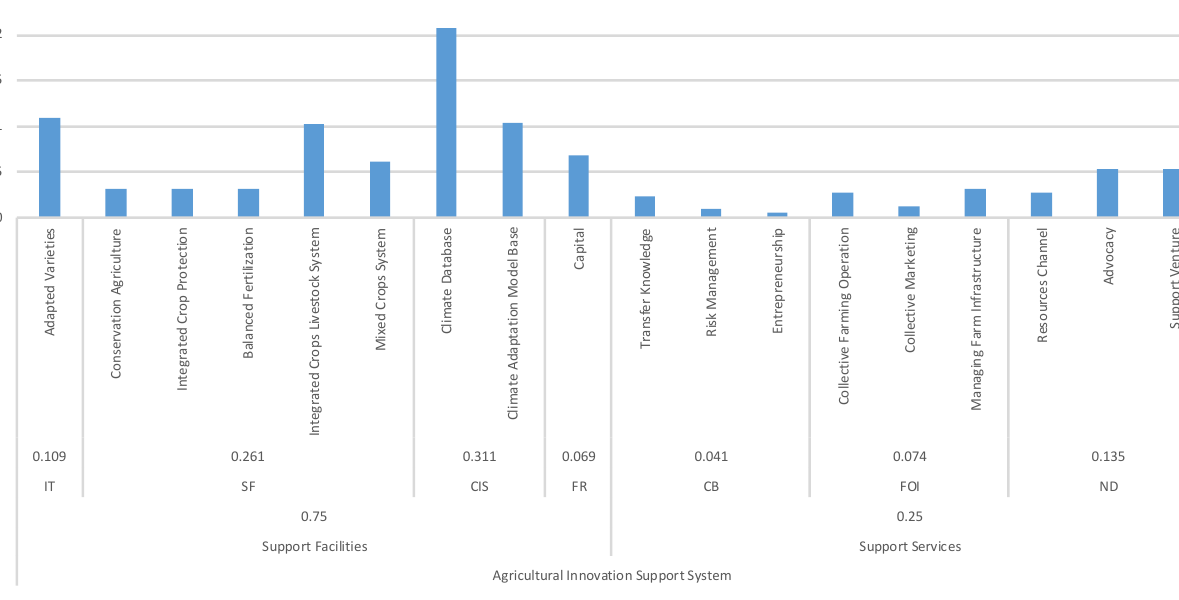
Figure 7. Priority number of agricultural innovation support system for Robusta farmers.